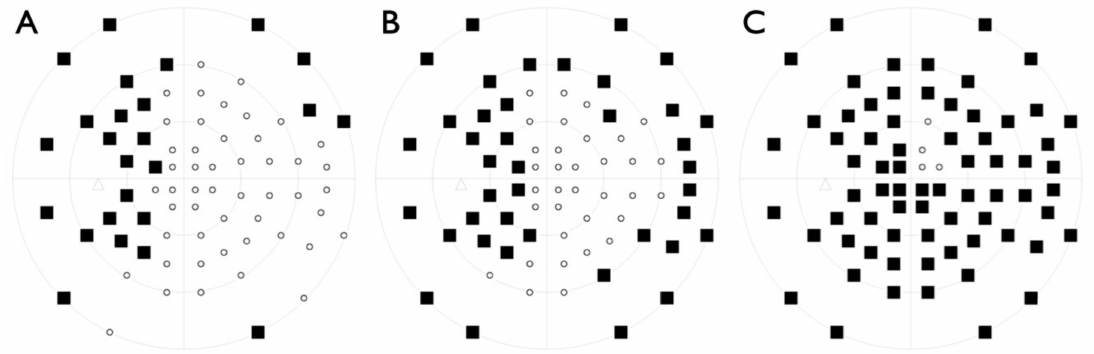
Figure 7. Visual field progression in patient IV:2 from family BD 35 between ( A ) 51, ( B ) 56 and ( C ) 60 years of